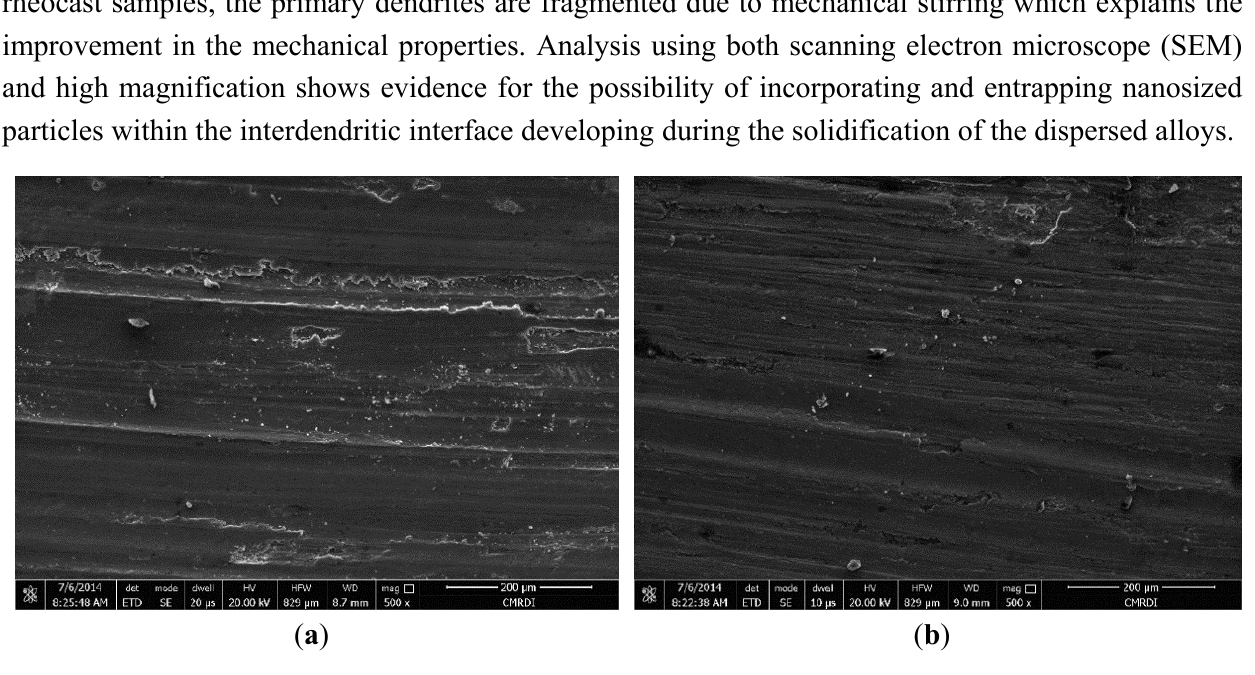
Figure 16. SEM for wear surface of ( a ) 1 weight% Al 2 O 3 and ( b ) 2 weight% Al 2 O 3